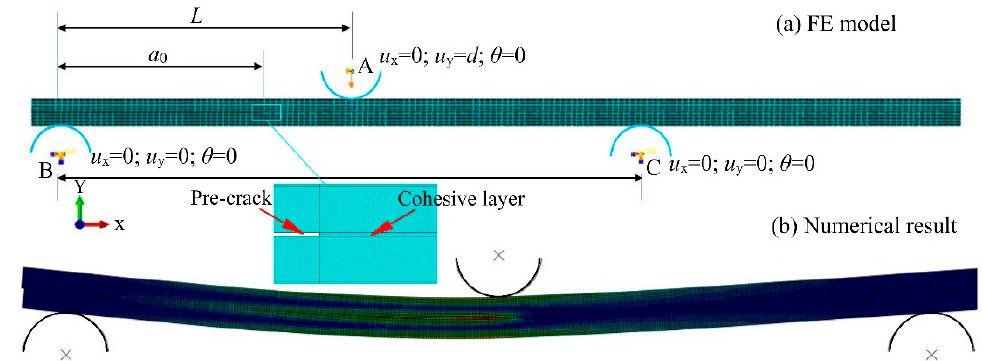
Figure 9. Simulation of the ENF specimen ( a ) FE model and ( b ) numerical result.